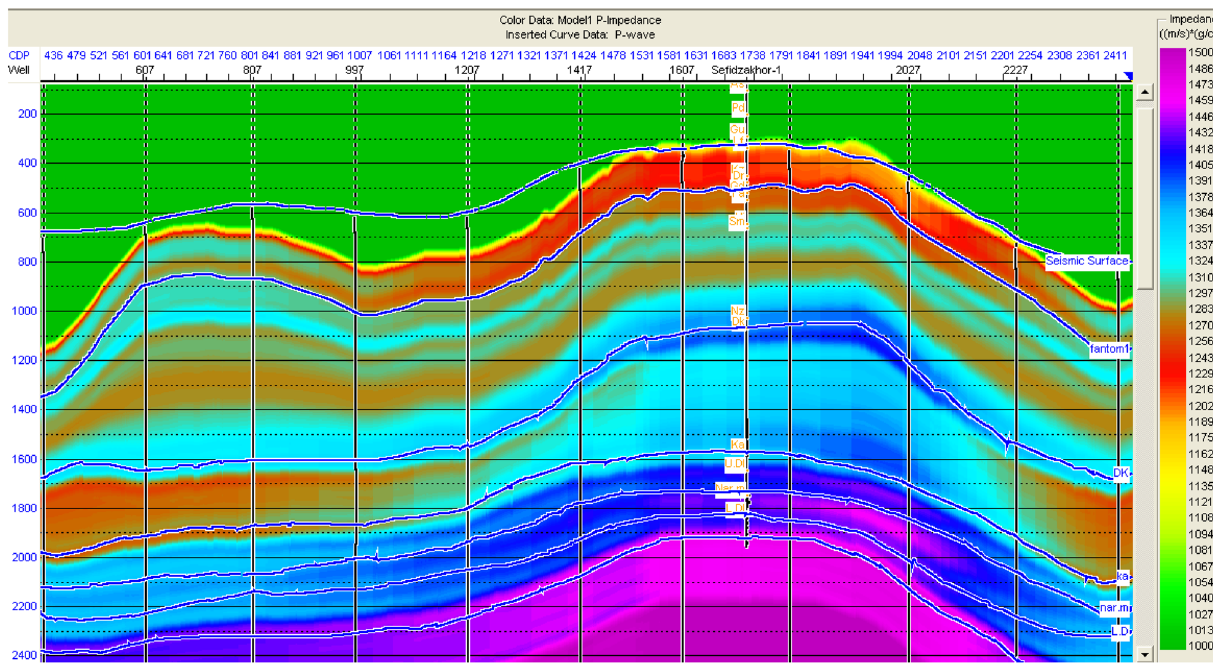
Fig. 3 Full well wavelet; a frequency domain, b time domain, c the result of cross-correlation between synthetic and seismic trace. The maxi- mum correlation peak is 50.03% at the time shift 29 ms. d Correct p -wave and time-depth shift for inversion